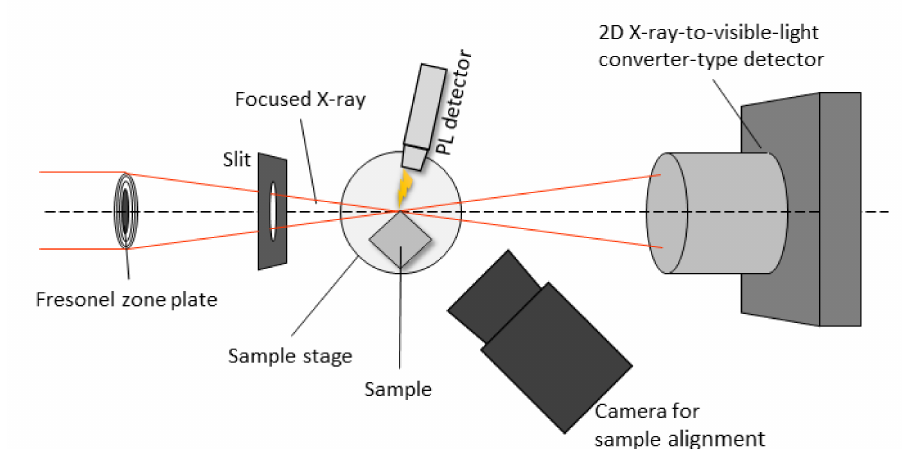
Figure 2. The experimental set-up used in this study. A small piece of the deposited CuO/Cu 2 O/ZnO substrate was mounted horizontally on a stage, and a focused X-ray beam was irradiated at the square corner of the sample, as shown in Figure 2. The sample stage had high-precision drive mechanisms for the horizontal, vertical, and rotational movement. Initially, the sample position was roughly adjusted based on the camera image for sample alignment. The detailed position was further calibrated using a 2D X-ray-to-visible light converter-type detector, which consisted of a scintillator, an optical lens, and a CMOS camera (Hamamatsu Photonics K.K., ORCA- Flash4.0, Hamamatsu, Shizuoka, Japan), which was placed 150 mm behind the sample (see Figure 3).